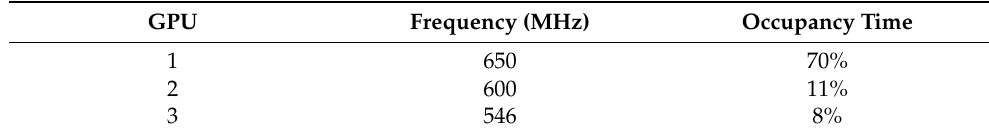
Table 6. GPU frequency